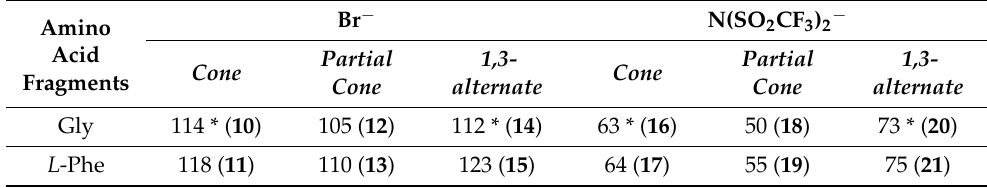
Table 2. Melting points ( ◦ C) of the macrocycles 10 – 21 containing amino acid fragments.